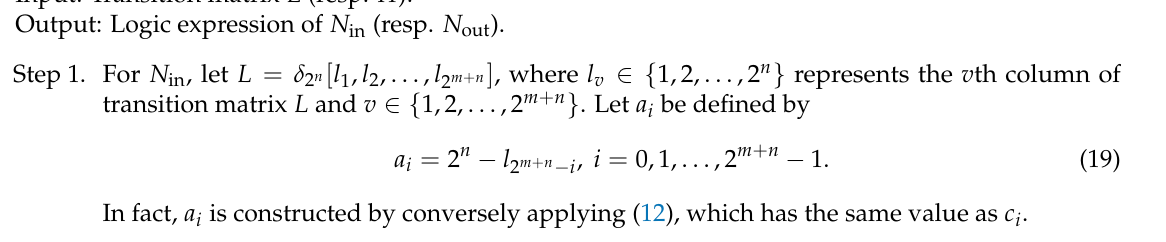
Algorithm 2 Algorithm for converting the algebraic expression back to the logic expression of BCN (7). Input: Transition matrix L (resp. H